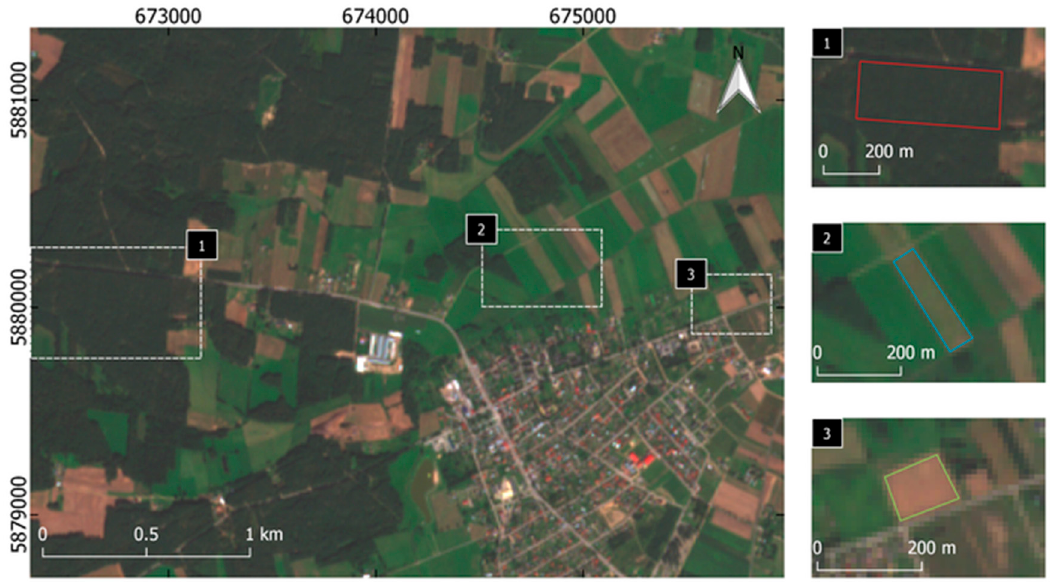
Figure 3. Locations of samples (red for forest, blue for mown meadow, and green for bare soil).